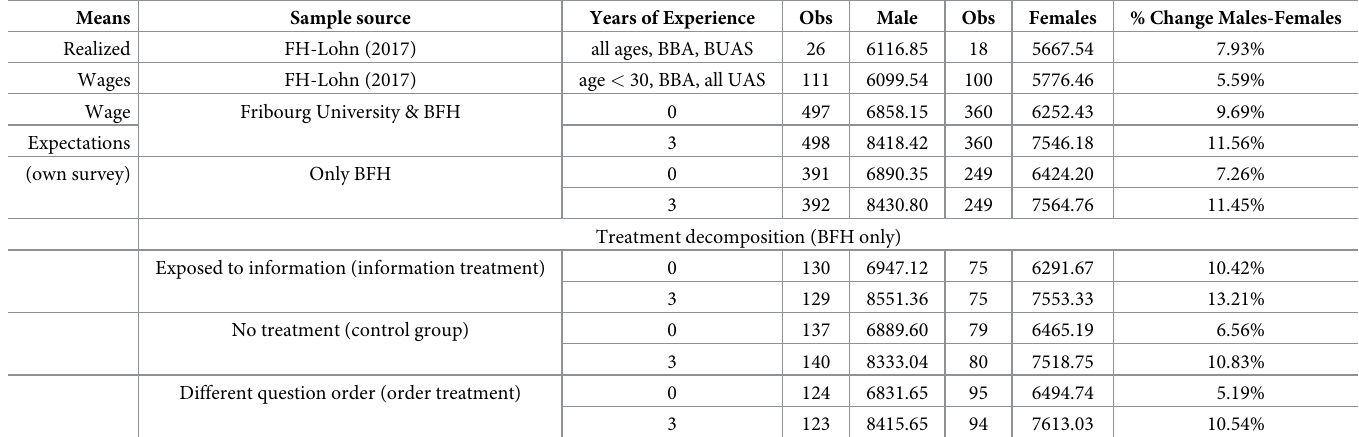
Table 1. Descriptives: Realized wages and wage